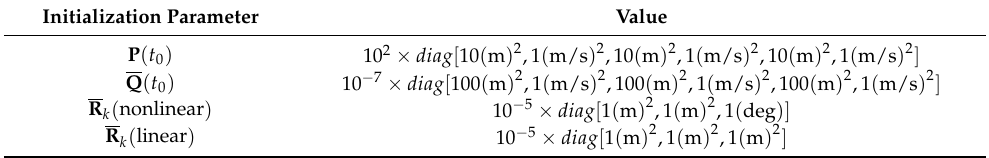
Table 1. Parameter settings. Initialization